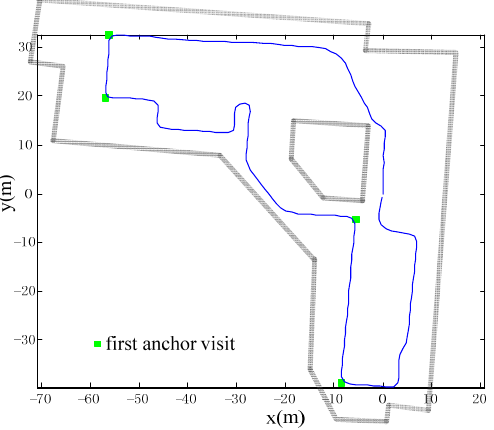
Figure 13. Test two: Library scenario with few anchor revisits ( a ) Raw trajectory with only one anchor revisit; ( b ) calibrated trajectory with better consistency in the circled area.